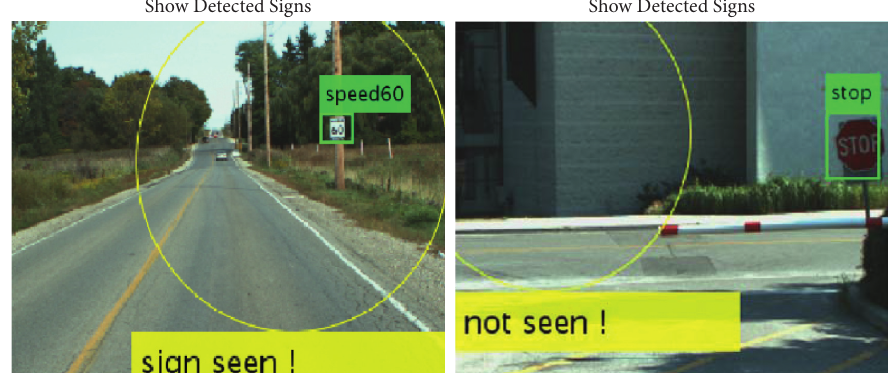
Figure 6: Examples of signs in attention area of driver and Table 3: Summary of traffic sign classification results.